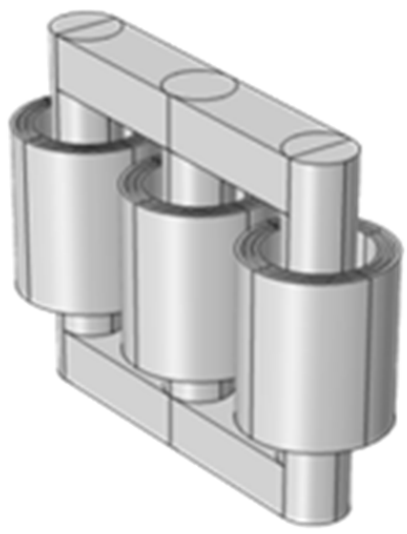
Figure 1. Three-dimensional finite element model of reactor. Table 1. Relevant material parameters.